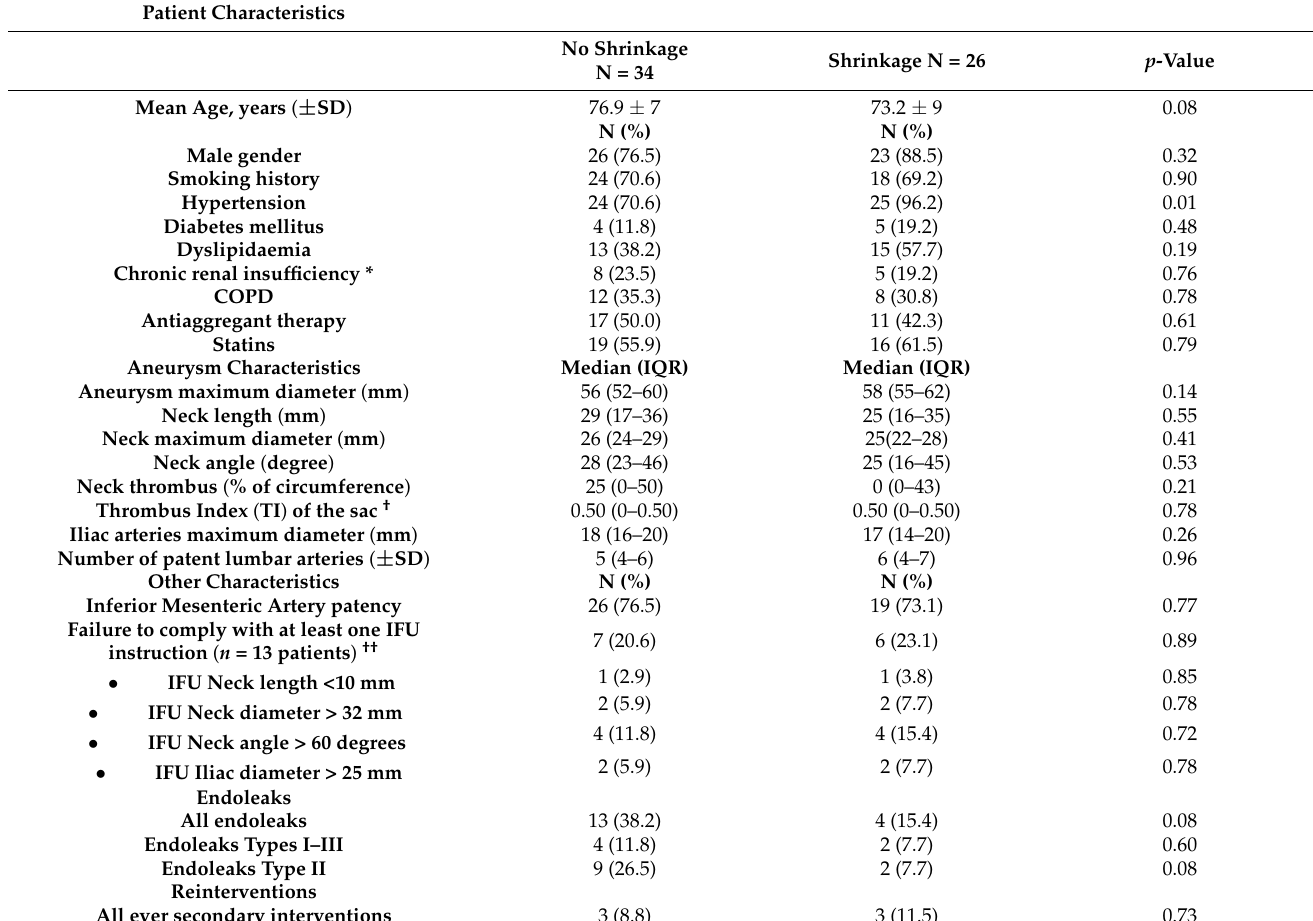
Table 2. Main characteristics of 60 patients undergoing EVAR for infrarenal aortic aneurysm according to sac shrinkage ≥ 5